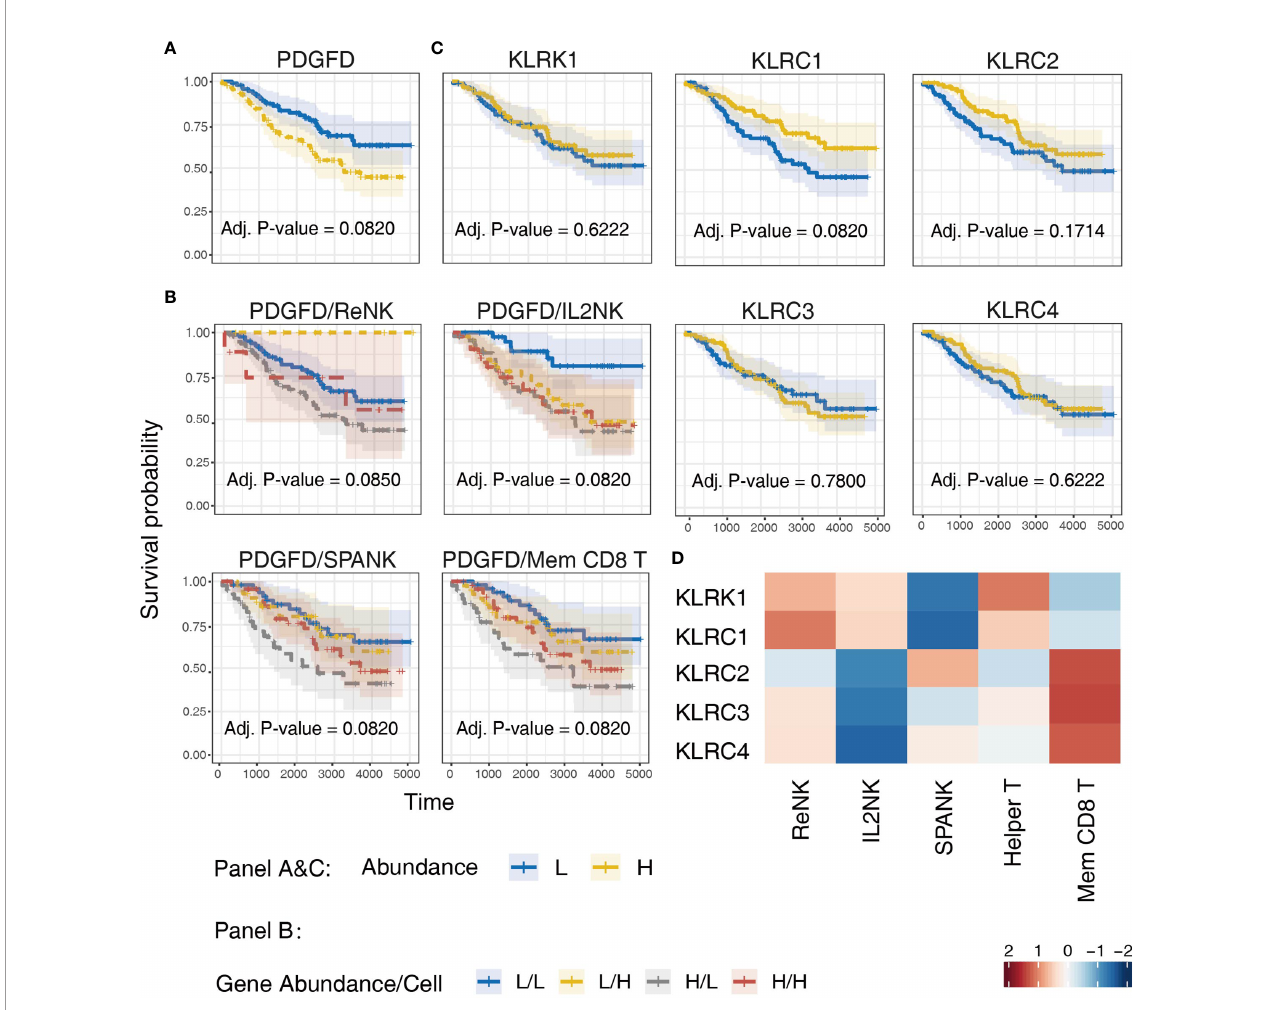
FIGURE 7 | Validation of TCGA fi ndings using the CGGA LGG dataset. KM curves displaying the survival of CGGA LGG patients split by median fraction into low (L) and high (H) tumor expression of: (A) PDGFD , (B) PDGFD and either NK cell or memory CD8 + T cell phenotypes, respectively, and (C) NK cell receptor genes, KLRK1, KLRC1, KLRC2, KLRC3 , or KLRC4 , respectively. KM curves display the survival of LGG patients plotted in all combinations for each stratum. (D) Heatmap displaying correlations between the expression of each NK cell receptor transcript (y-axis) and NK cell and T cell phenotypes (x-axis) in CGGA LGG tumors,